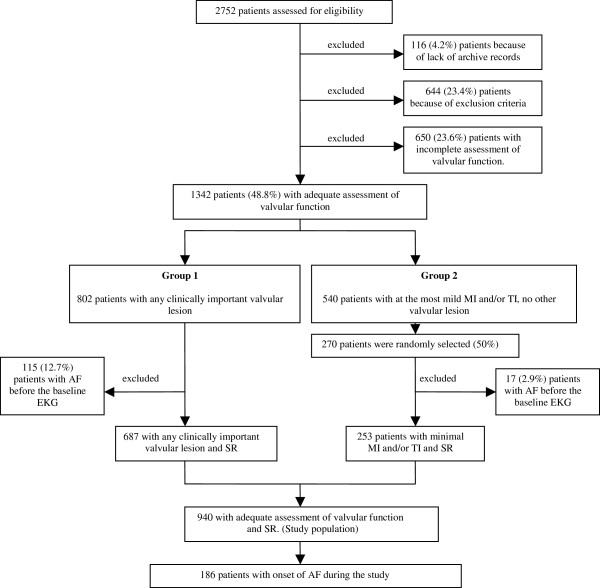
Enrolment and outcomes.SR, sinus rhythm; AF, atrial fibrillation; ECG, electrocardiogram; AS, aortic stenosis; AR, aortic regurgitation; MR, mitral regurgitation; TR, tricuspid regurgitation.